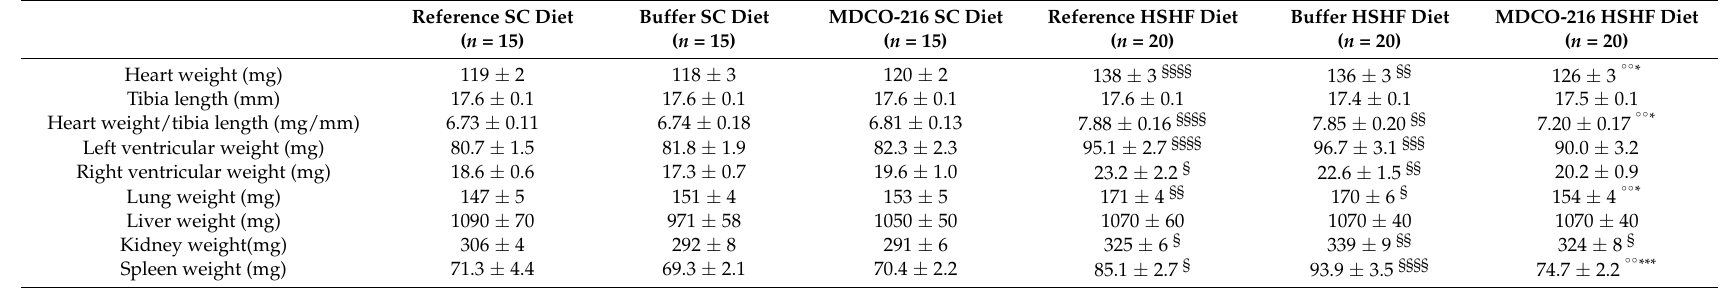
Table 4. Organ and tissue weights in reference, buffer, and MDCO-216 C57BL/6N mice.